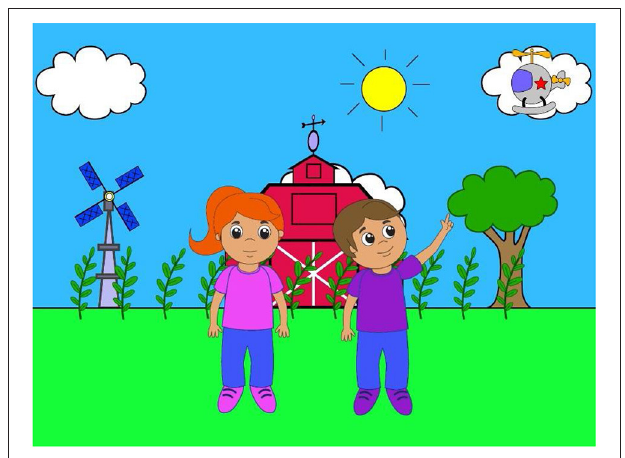
FIGURE 1 | A screen shot from an animated sequence designed to measure an aspect of social cognition (social sensitivity) in infants and toddlers.